Question: Looking at the figure, what chart type is it?
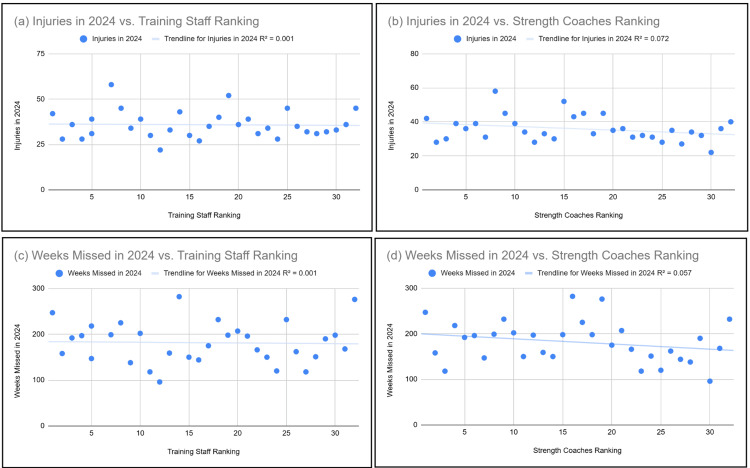
Answer: scatter